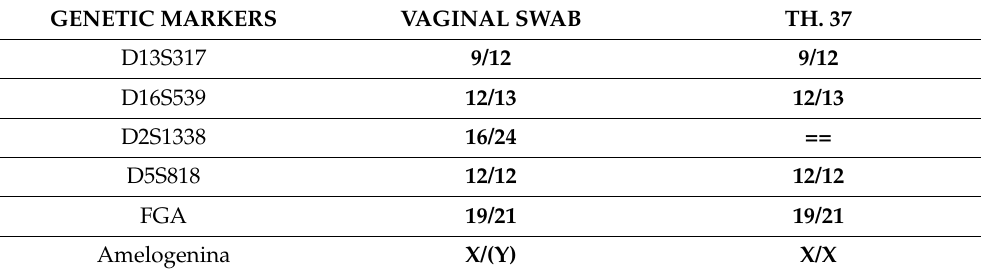
Table 2. Cont . GENETIC